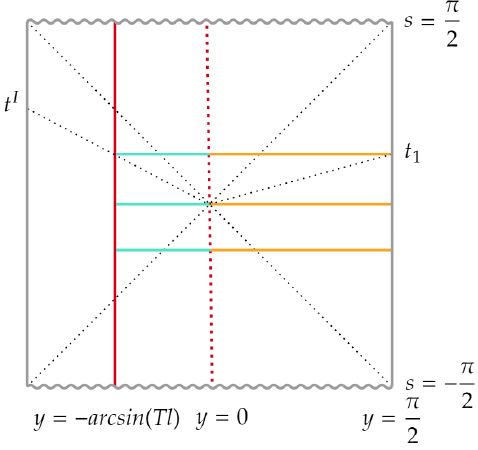
Figure 7 . BTZ black hole in s - y coordinate. The red solid line is the brane with tension T , the red dashed line is the brane with tension zero. The line orthogonal to the brane is the RT